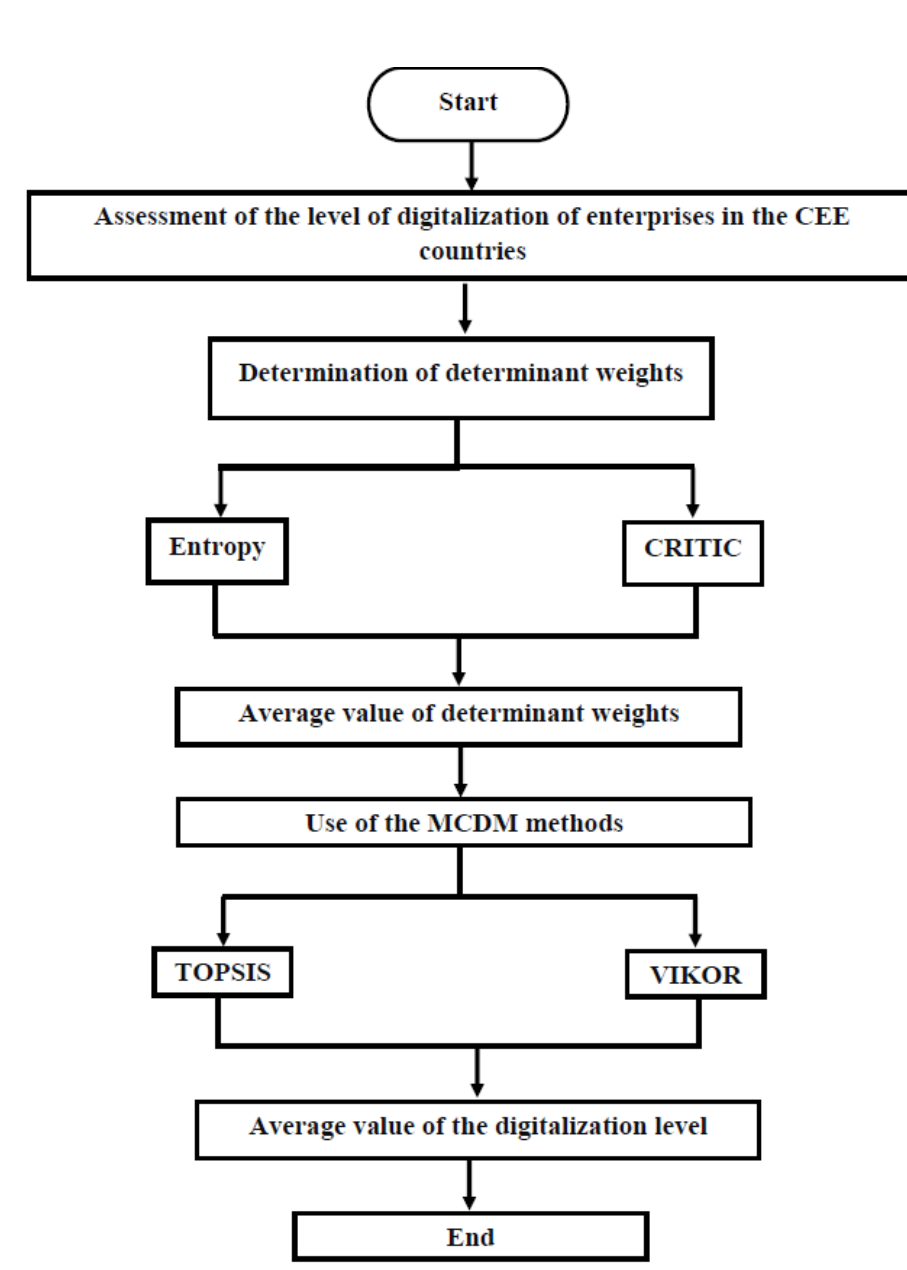
Figure 4. MCDM hybrid approach to assess the level of digitalization of enterprises in the CEE countries. CRITIC